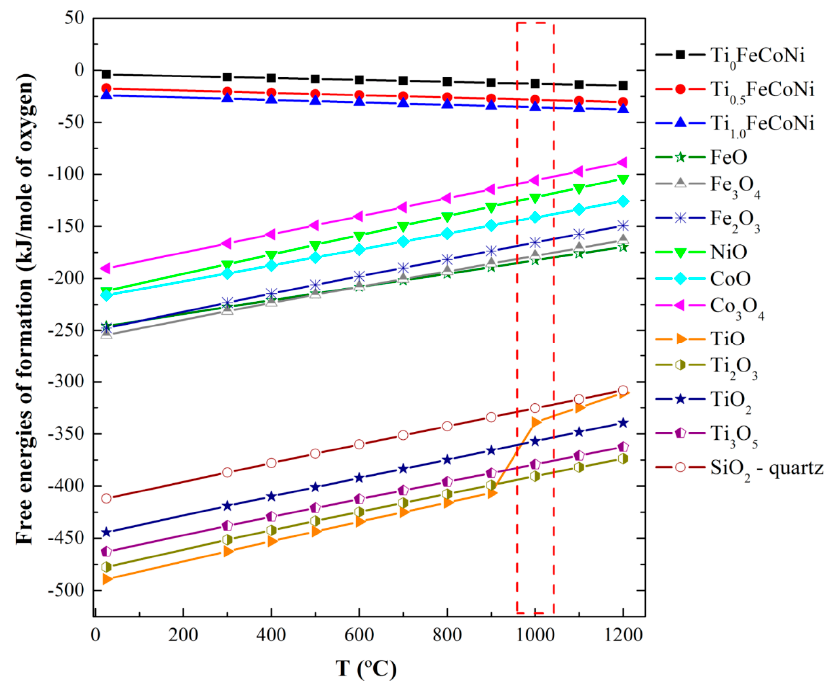
Figure 5. Free energies involved in the formation of Ti x FeCoNi metal and A n O m (A = Ti, Fe, Co, Ni, and Si) oxides. and Si)